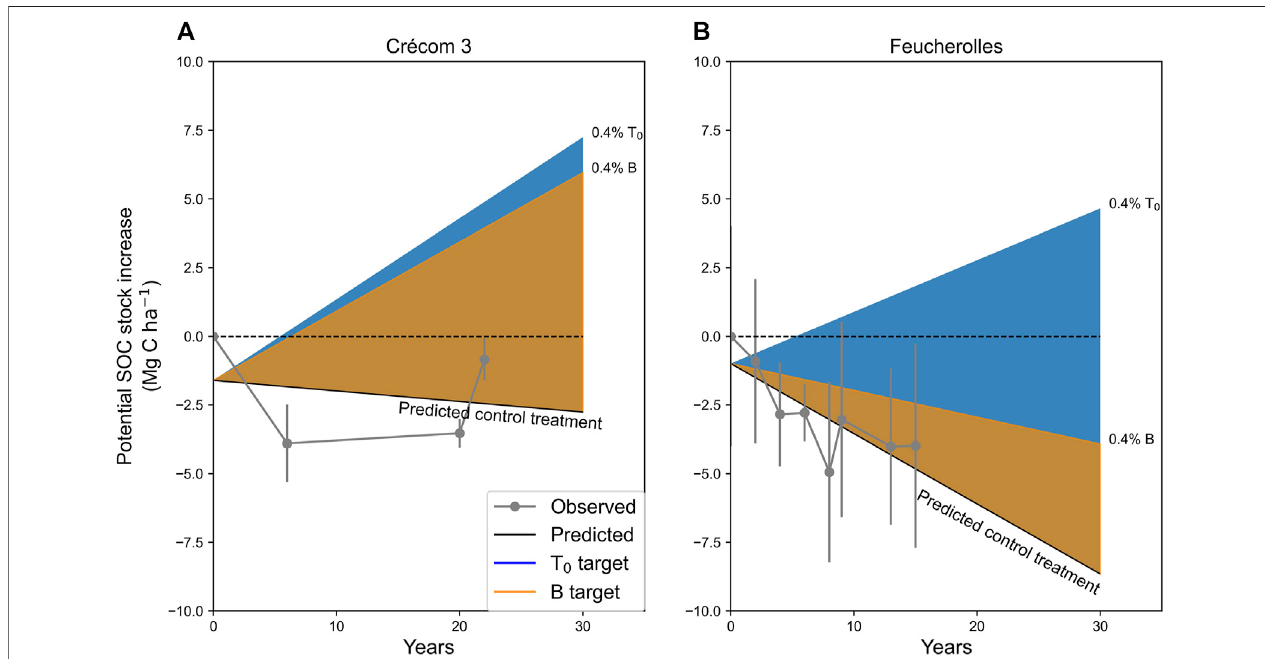
FIGURE 1 | Theoretical soil organic carbon (SOC) stock evolution needed to reach an average annual 0.4% SOC stock increase for 30 years, based on two calculation methods (T 0 and B, calculated with Eq. 4 and Eq. 5 , respectively) for (A) Crécom 3 and (B) Feucherolles (detailed demonstration available in Appendix A ). Observed SOC stocks (at 0 – 30 and 0 – 29 cm depth, respectively) and predicted SOC stocks (with a linear regression) for the control treatments are normalized against initial SOC stocks.